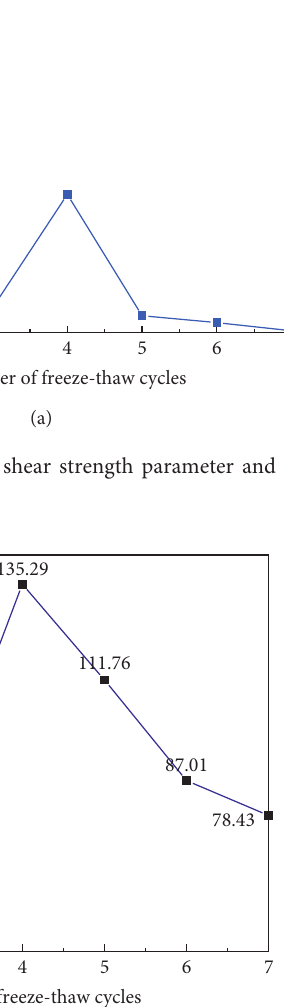
Figure 15: Relationship between unconfined compressive strength and freezing-thawing